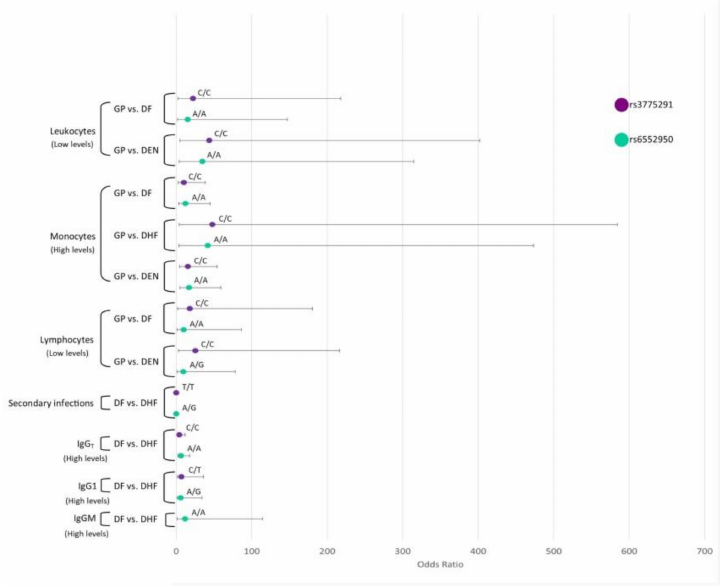
Figure 1. Interaction analysis of TLR 3 SNPs and the hematological covariates. Interaction analysis of TLR3 SNPs and the levels of hematological covariates leukocytes, lymphocytes, monocytes, and immunoglobulin levels of IgM, total IgG, IgG1, and secondary dengue infections. Odds ratios and confidence intervals are shown in abscissa axis and genotypes are indicated above the odds ratios